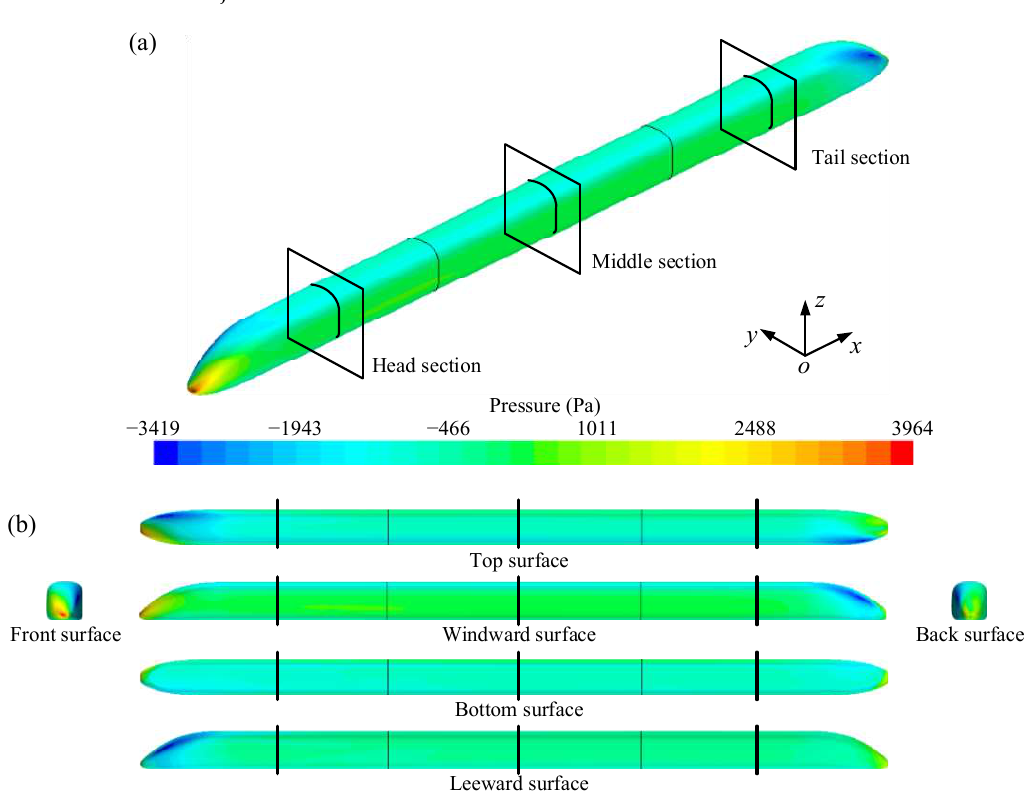
Figure 7. Pressure distribution on the train surface ( U = 20 m/s, α = 90°, V = 300 km/h, V R = 85.7 m/s, β = 13.5°): ( a ) three- dimensional surface pressure; ( b ) pressure distribution on different surfaces.